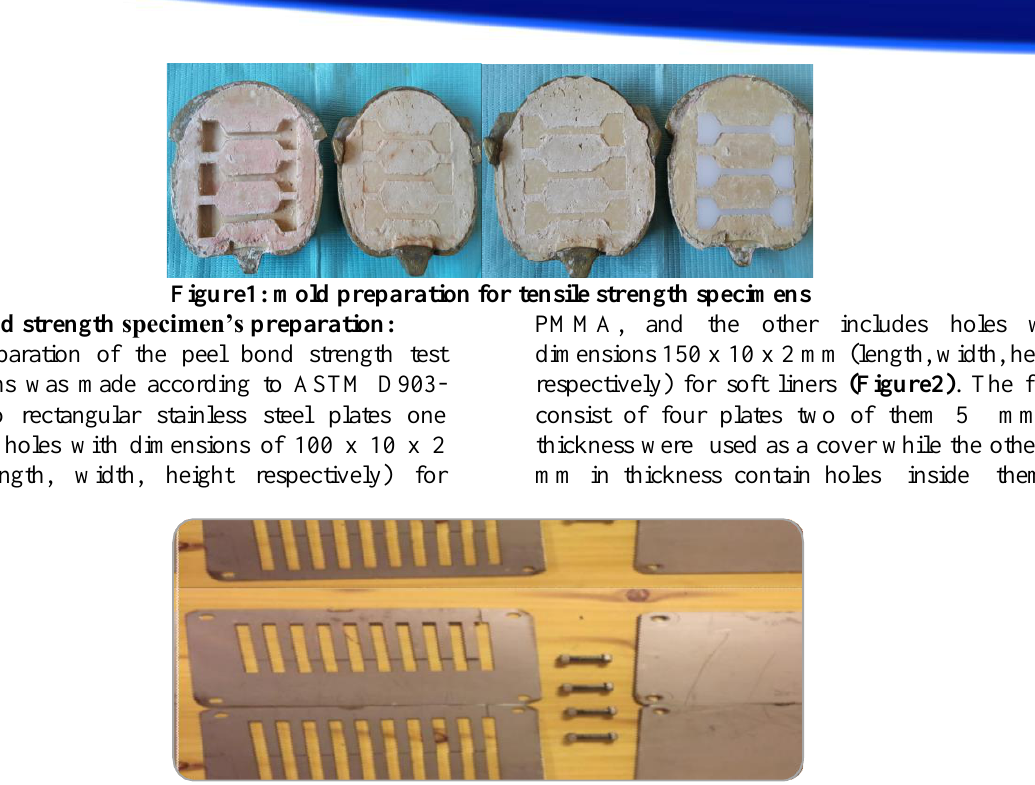
Figure2: Prepared plates for peel bond strength specimens.